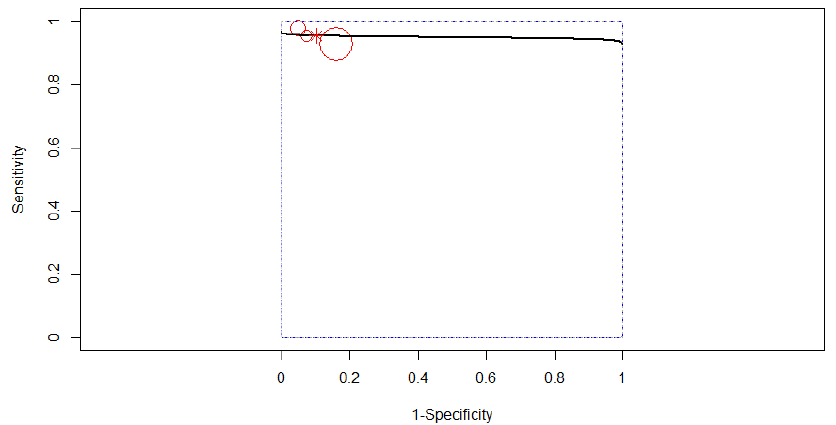
Figure 5. The SROC curve for deep learning-based computer-aided diagnosis.